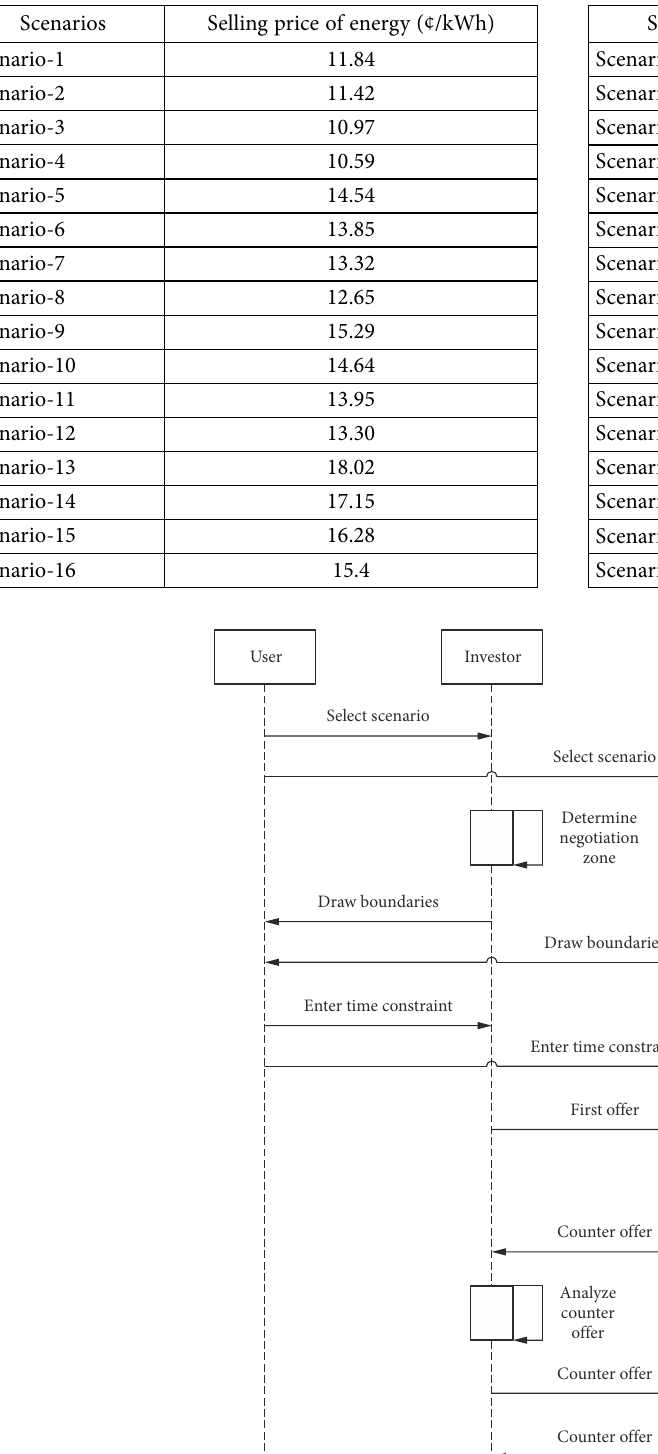
Table 3. Negotiation results for each scenario